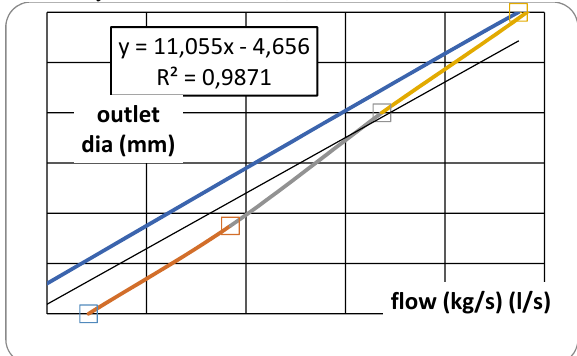
Fig. 4-8. Simple choice of an outlet diameter from the needed mass flow – from the simulations above.